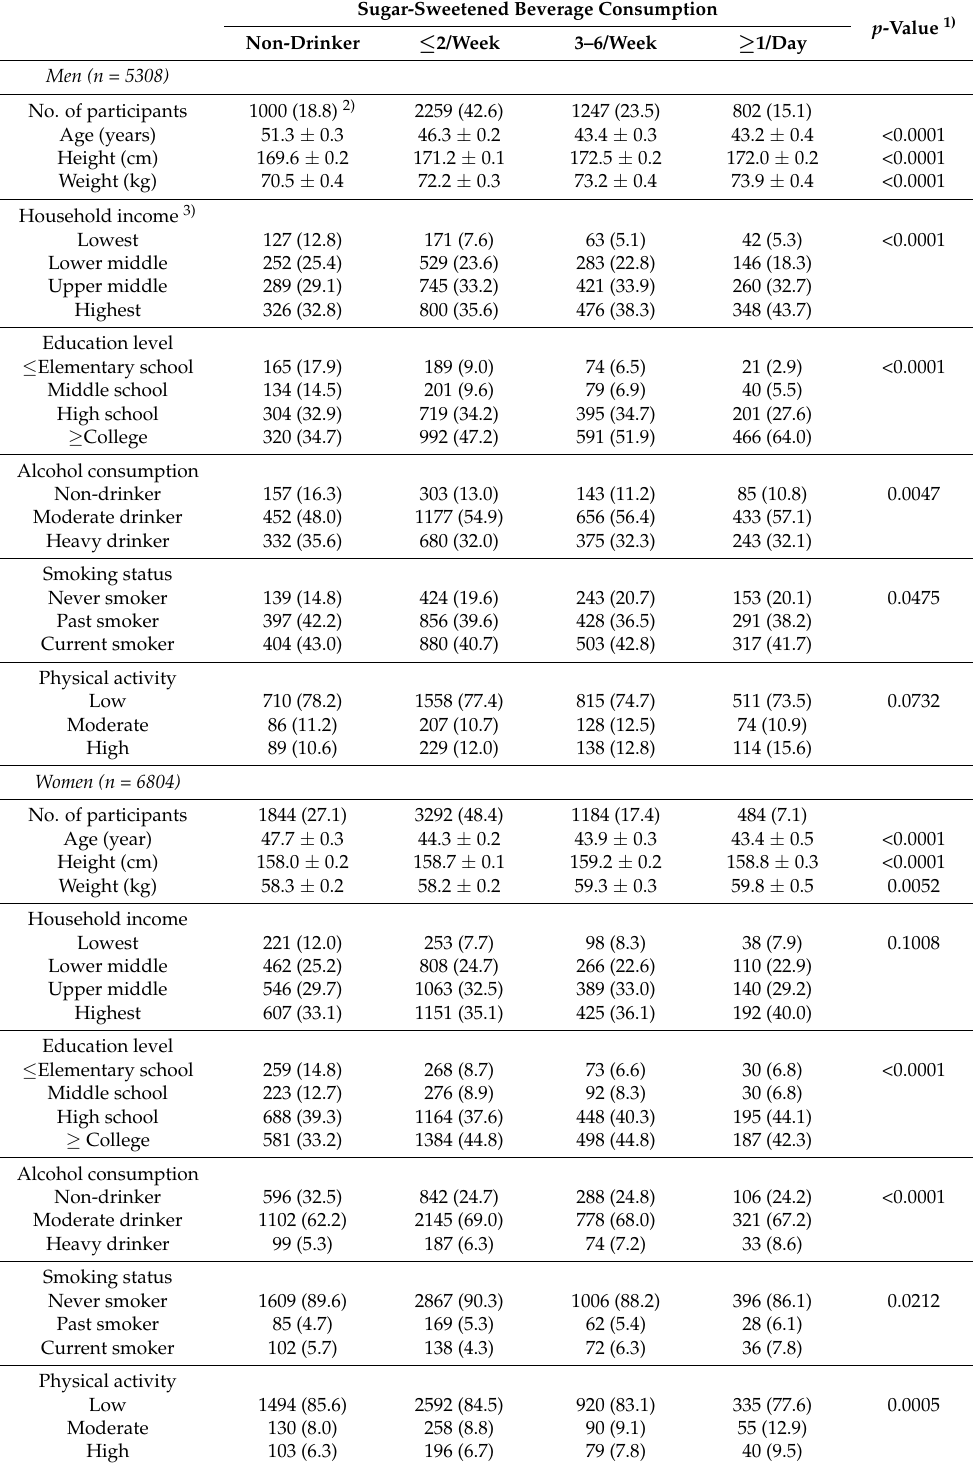
Table 1. General characteristics of participants according to sugar-sweetened beverage